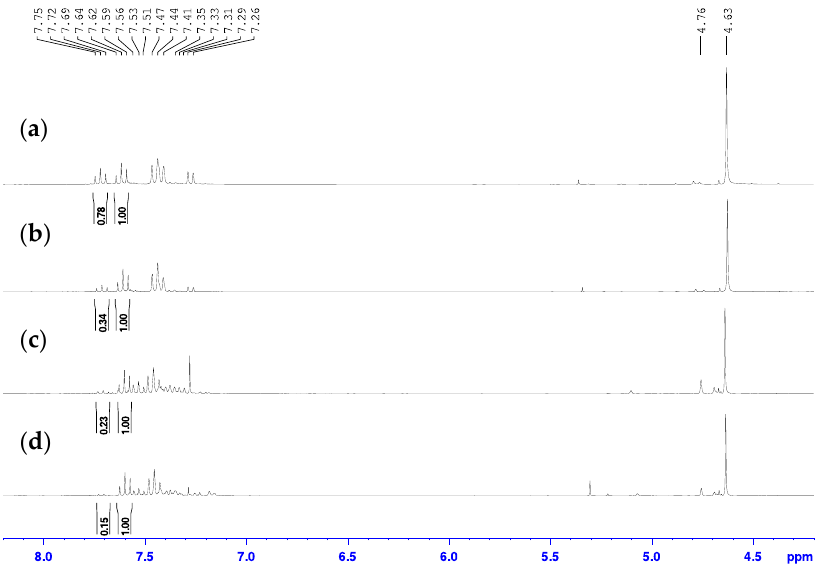
Figure 4. Overlay of the 1 H-NMR spectra for the product mixtures from the reaction of 2-bromo-6- hydroxymethylpyridine with SOCl 2 ( a ) neat at 40 ◦ C, ( b ) neat at r.t., ( c ) neat at 0 ◦ C, ( d ) in DCM at 0 ◦ C in CDCl 3 .